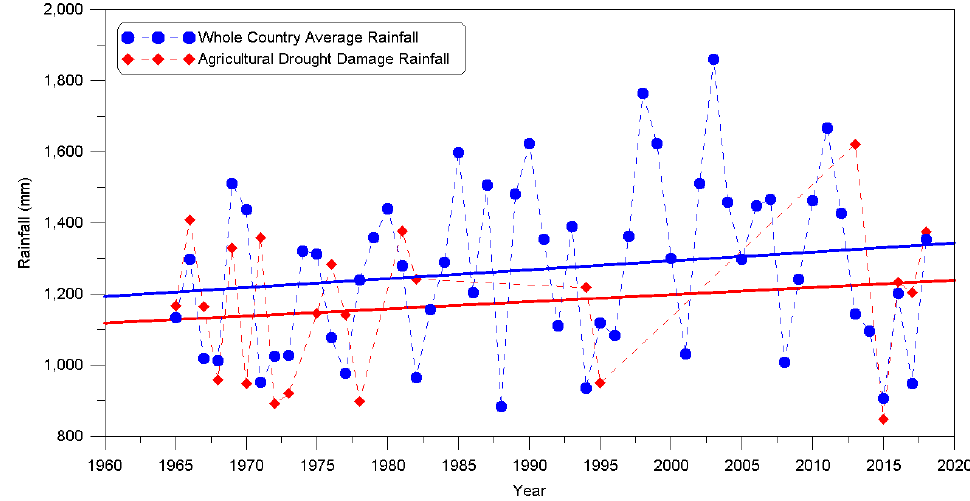
Figure 8. Setting up rainfall for disaster prevention relevant to agricultural droughts by year.